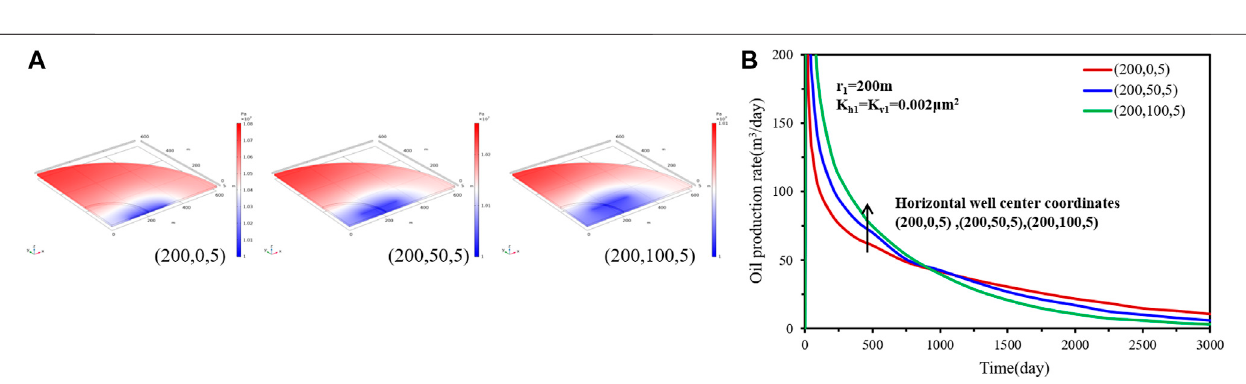
Frontiers in Energy Research |